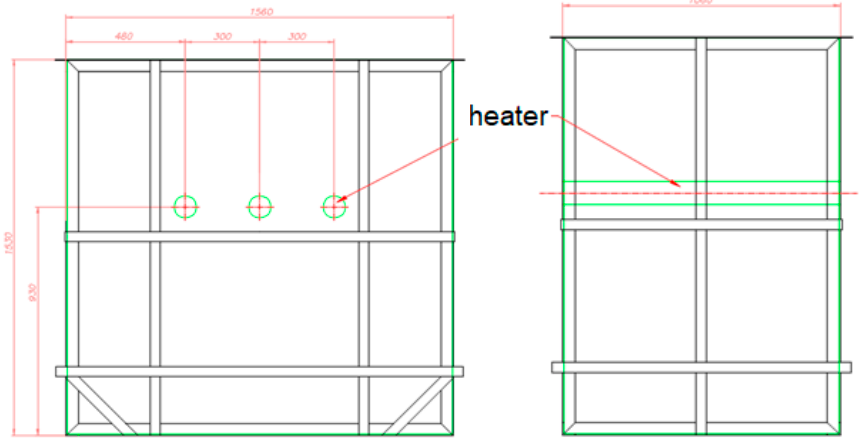
Figure 1. Scheme of the experimental setup.